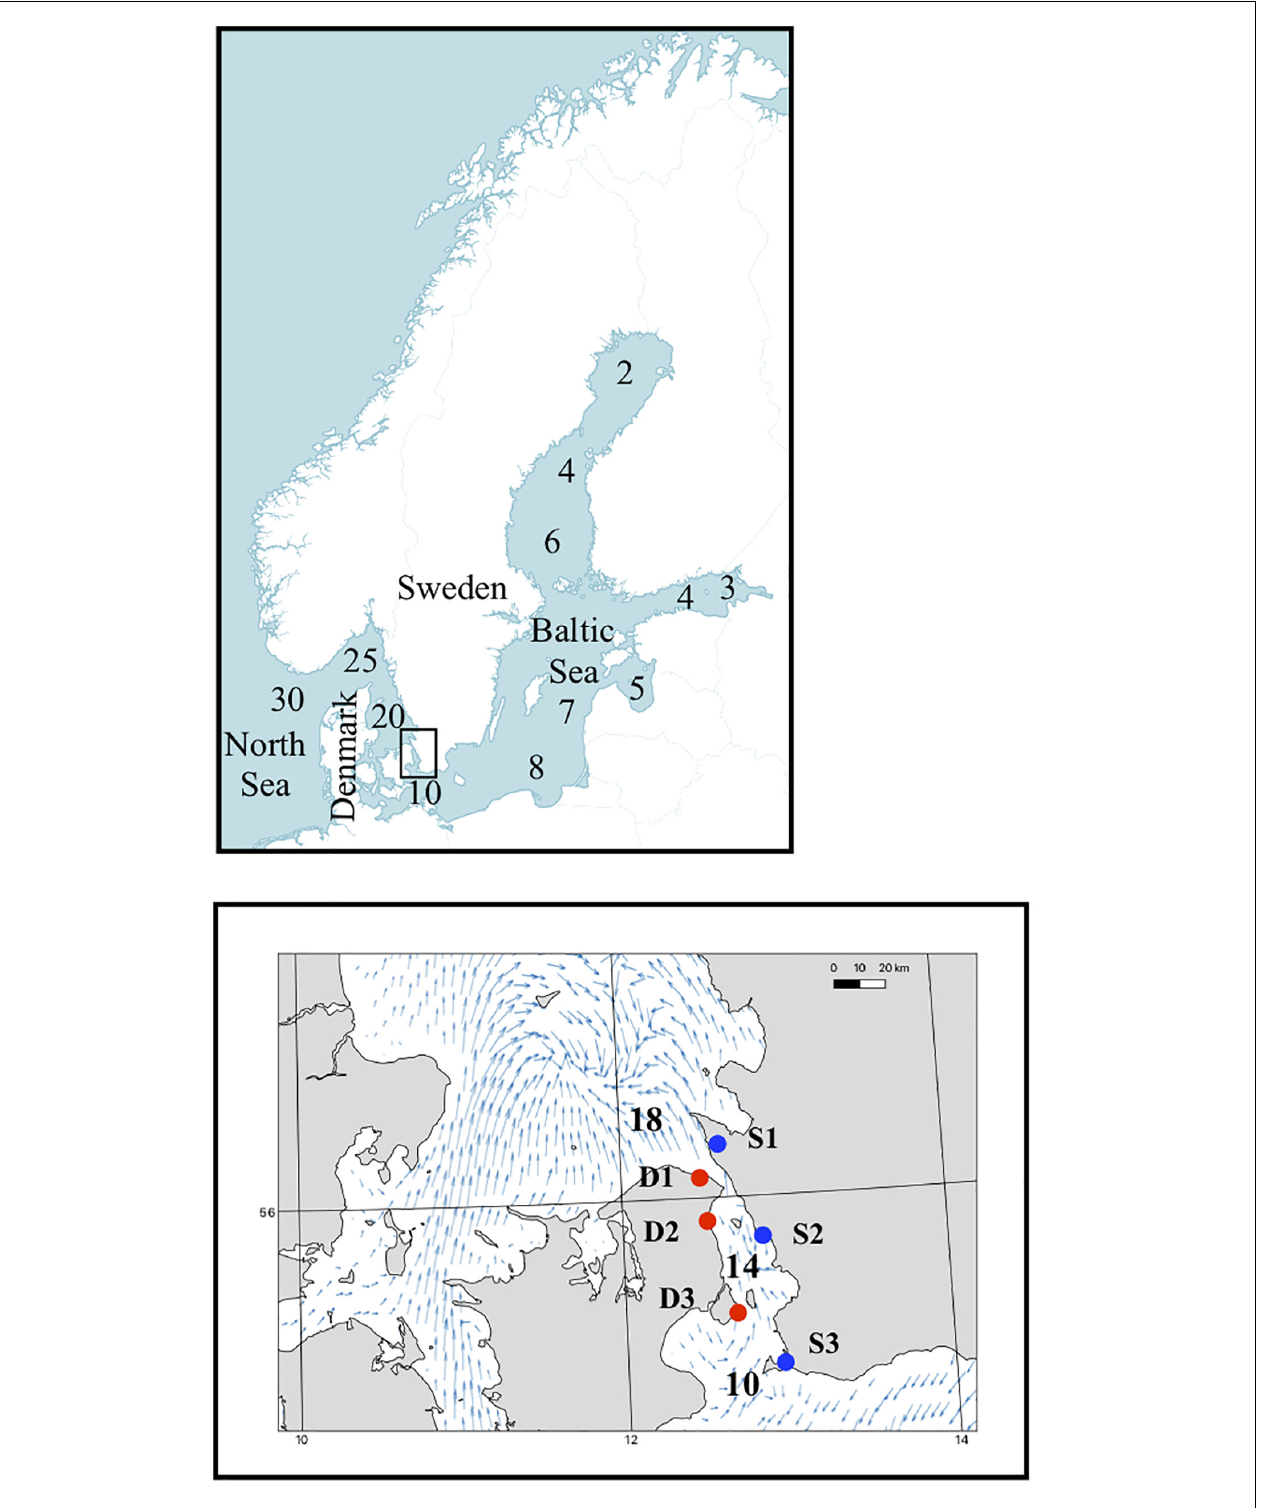
FIGURE 1 | Map of the study area and salinity gradient. Red dots represent the sites on the Danish side of the Öresund strait and the blue dots represent the Swedish sites, numbers on the map are average salinity values. Mean velocity field of modeled surface currents in southern Kattegat and the Öresund strait. Based on the circulation model NEMO-Nordic (Hordoir et al., 2019), currents in the surface layer (0–3 m) for the months June, July, and August were averaged for the years 1995–2002.